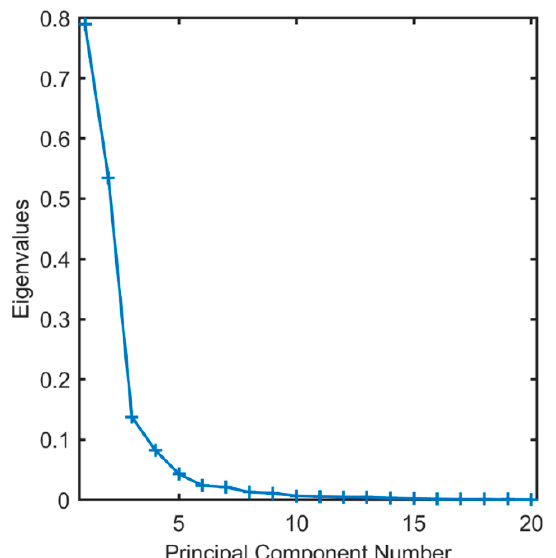
Figure A6. Scree plot showing decreasing eigenvalues as number of PCs increases. A “knee” occurs at PC6.